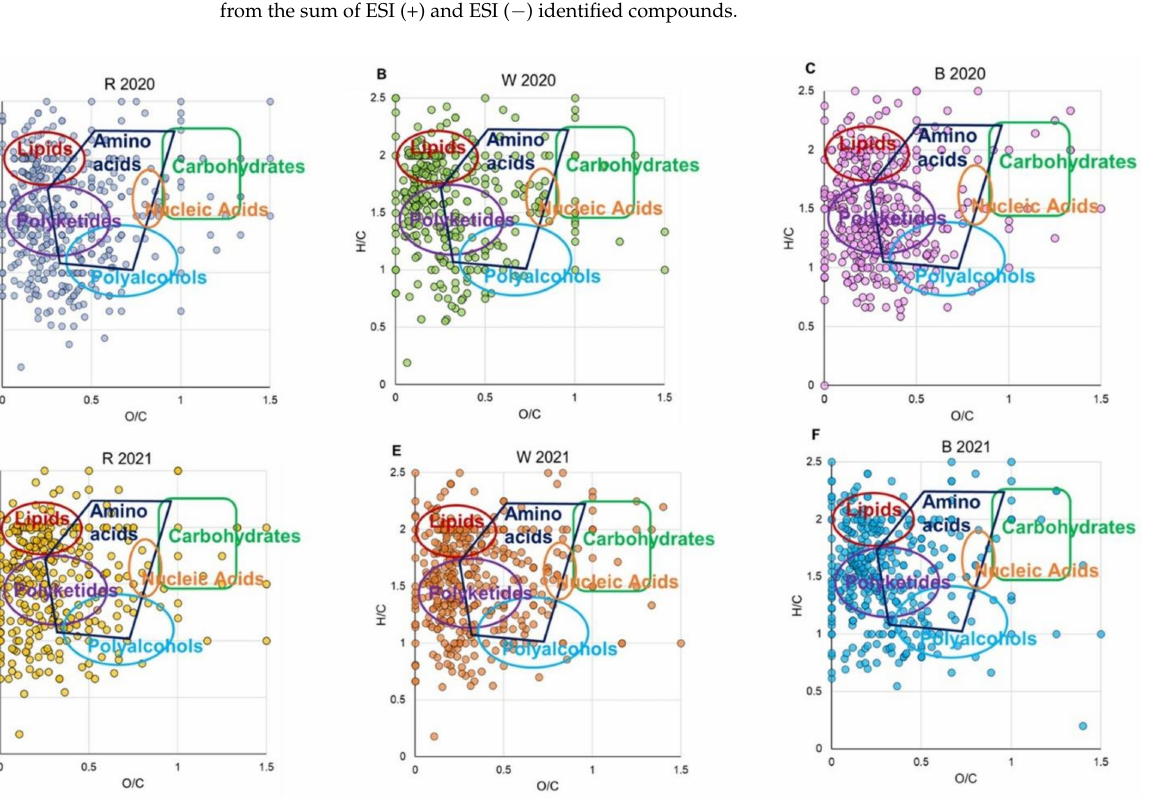
Figure 2. Van Krevelen diagrams (elemental plot) obtained from the molecular formulas achieved by ESI FT-ICR MS analyses of hydroalcoholic extracts of R 2020 ( A ), W 2020 ( B ), B2020 ( C ), R2021 ( D ), W2021 ( E ), and B2021 ( F ). Each point on the graph represents a distinctive molecular formula.